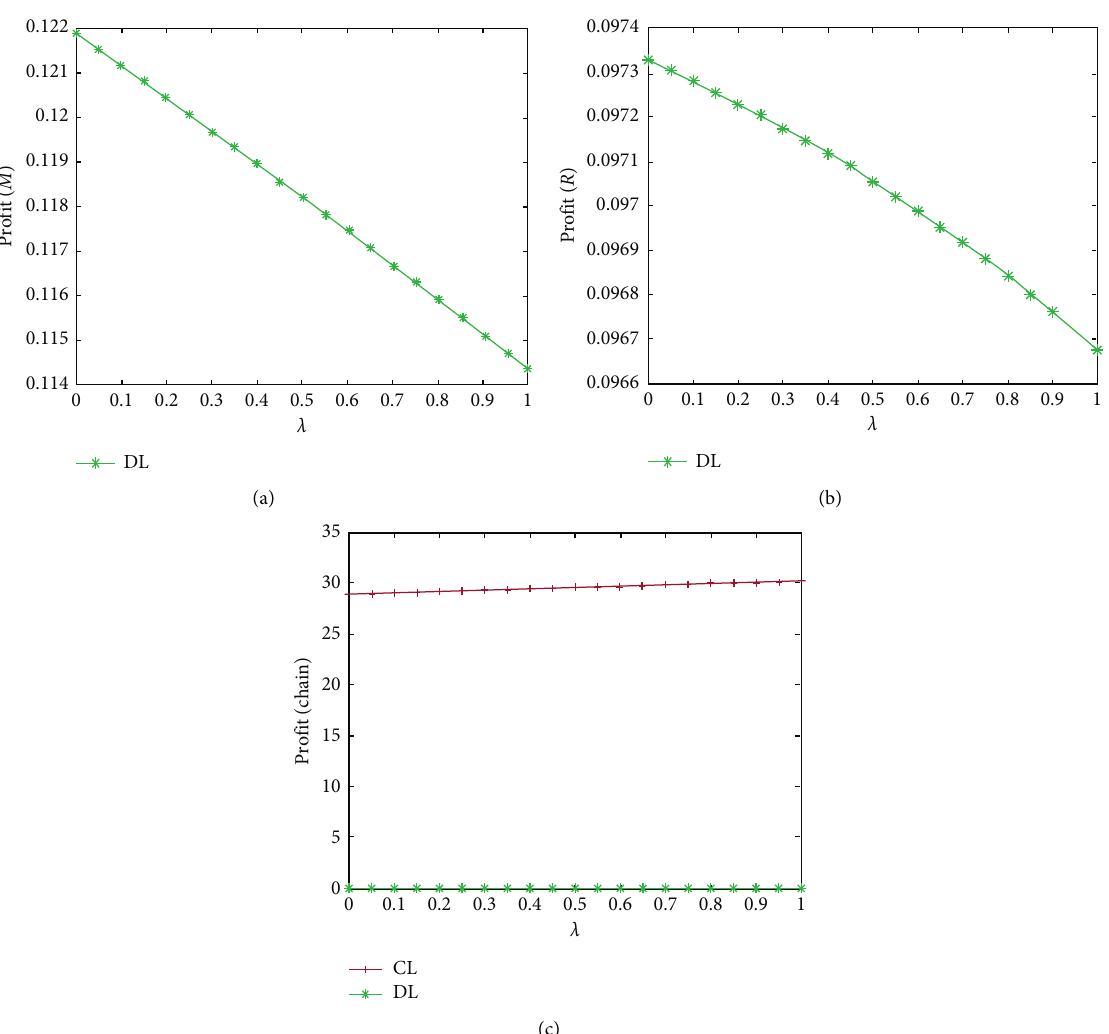
Figure 2: Effect of regret sensitivity coefficient on supply chain profit.